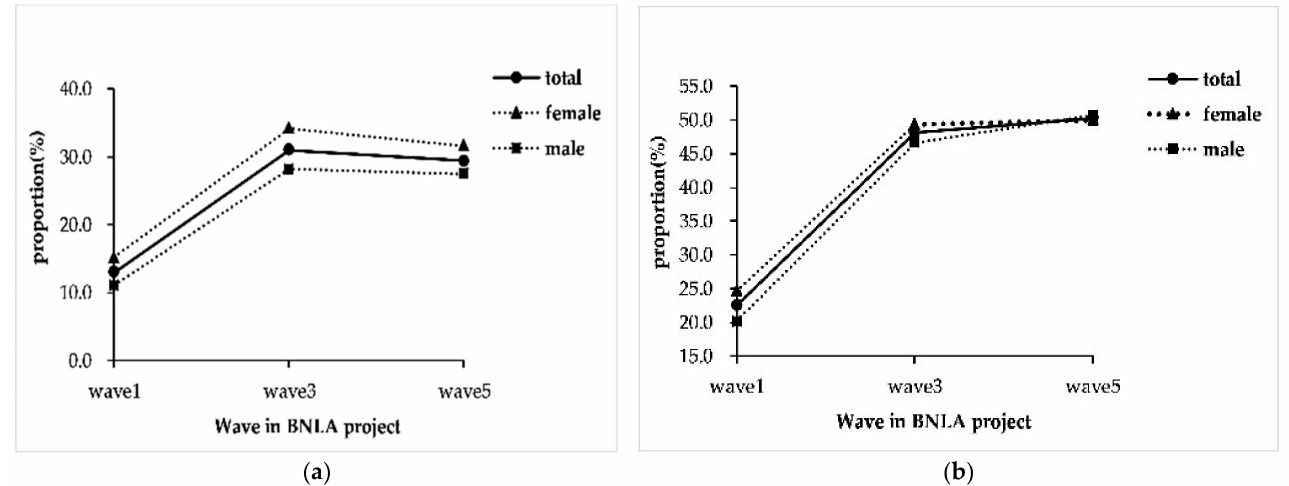
Figure 3. The trends of MHS utilization among resettled humanitarian migrants in Australia. Note: ( a ) The proportions of having MHS contacts in the overall participants; ( b ) The proportions of having MHS contacts in the participants with post-traumatic stress disorder (PTSD) and/or high risk of severe mental illness (HR-SMI). The difference between females and males was tested by chi-square test at each wave, with all p < 0.05 in ( a ) and all p > 0.05 in ( b ). MHS: mental health